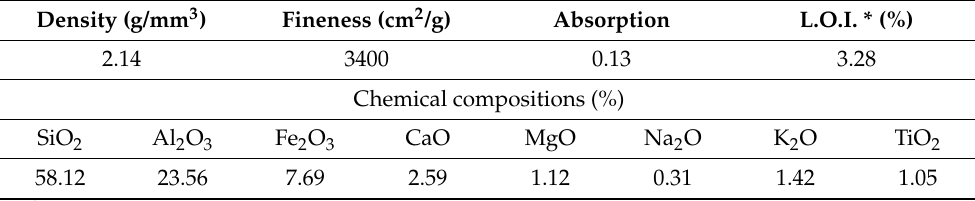
Table 2. Physical and chemical properties of the fly ash.